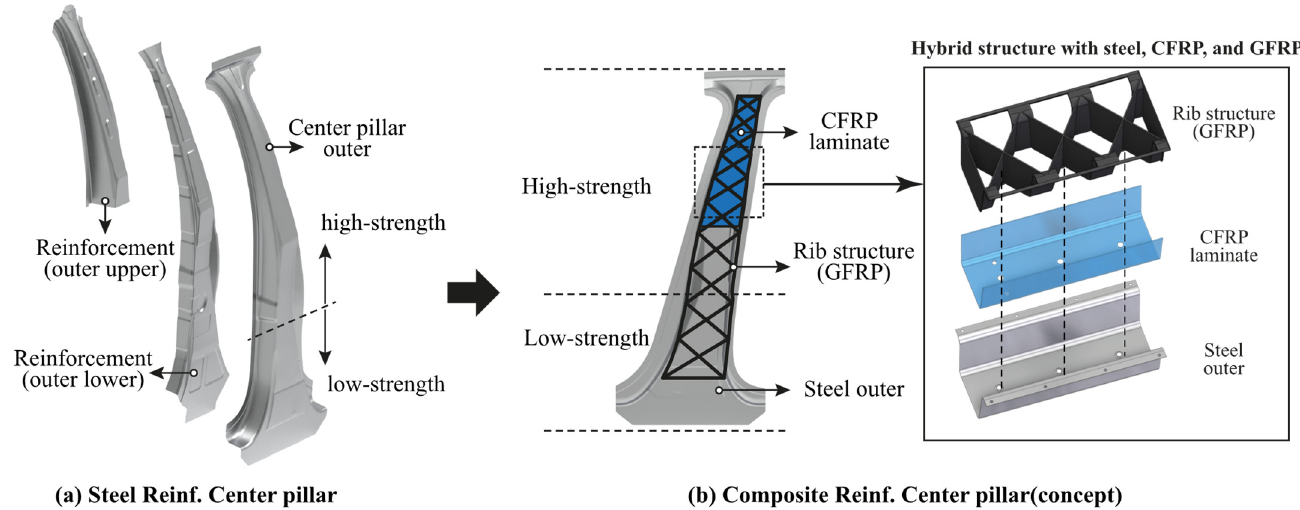
Figure 1. ( a ) Center pillar with steel reinforcements and ( b ) concept design of center pillar with composite reinforcements.